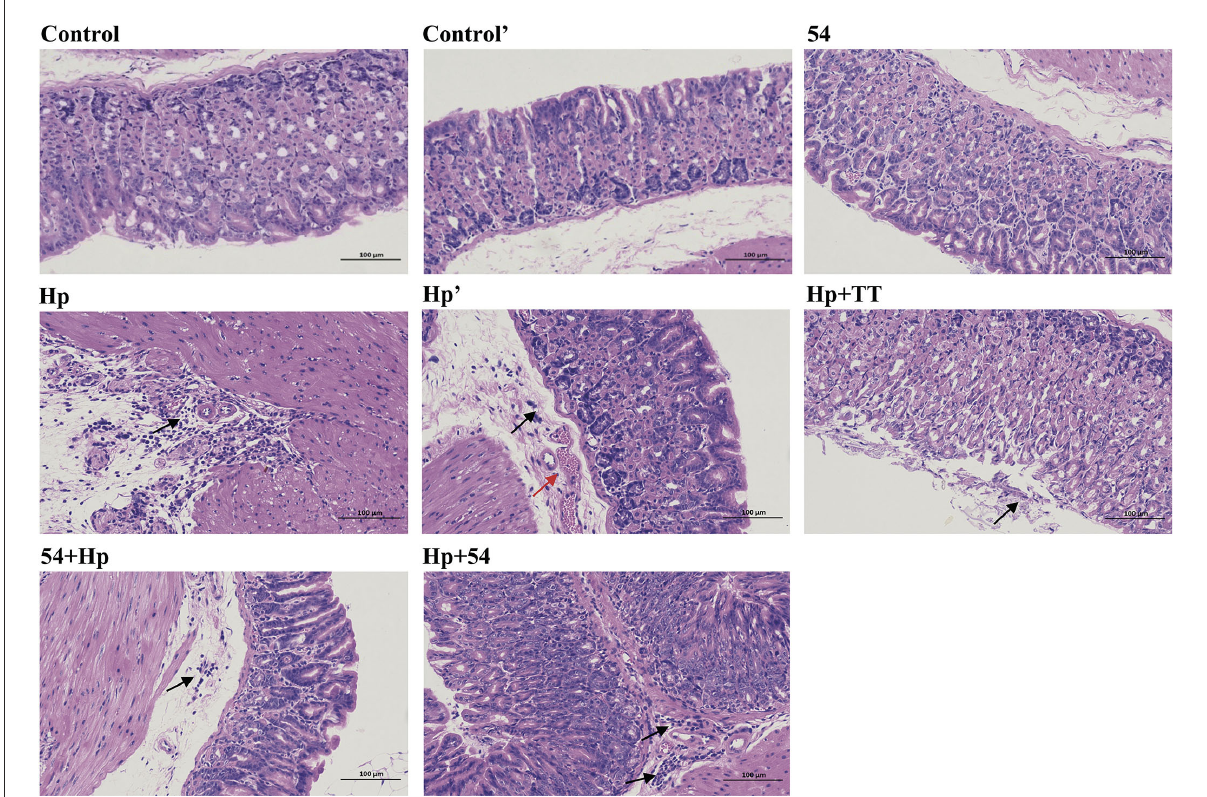
FIGURE5 Hematoxylin–eosin staining of the gastric tissues. Control, normal mice without prevention and infection in the preventive group; Control’, normal mice without infection and therapy in the therapeutic group; Hp, mice infected with H. pylori without prevention in the preventive group; Hp’, mice infected with H. pylori without therapy in the therapeutic group; 54 + Hp, pretreatment with L. paracasei ZFM54 before H. pylori challenge; Hp + 54, treatment with L. paracasei ZFM54 after H. pylori challenge; Hp + TT, treatment with triple therapy after H. pylori challenge. Black arrow, infiltration of inflammatory cells in lamina propria; red arrow, vascular congestion in the